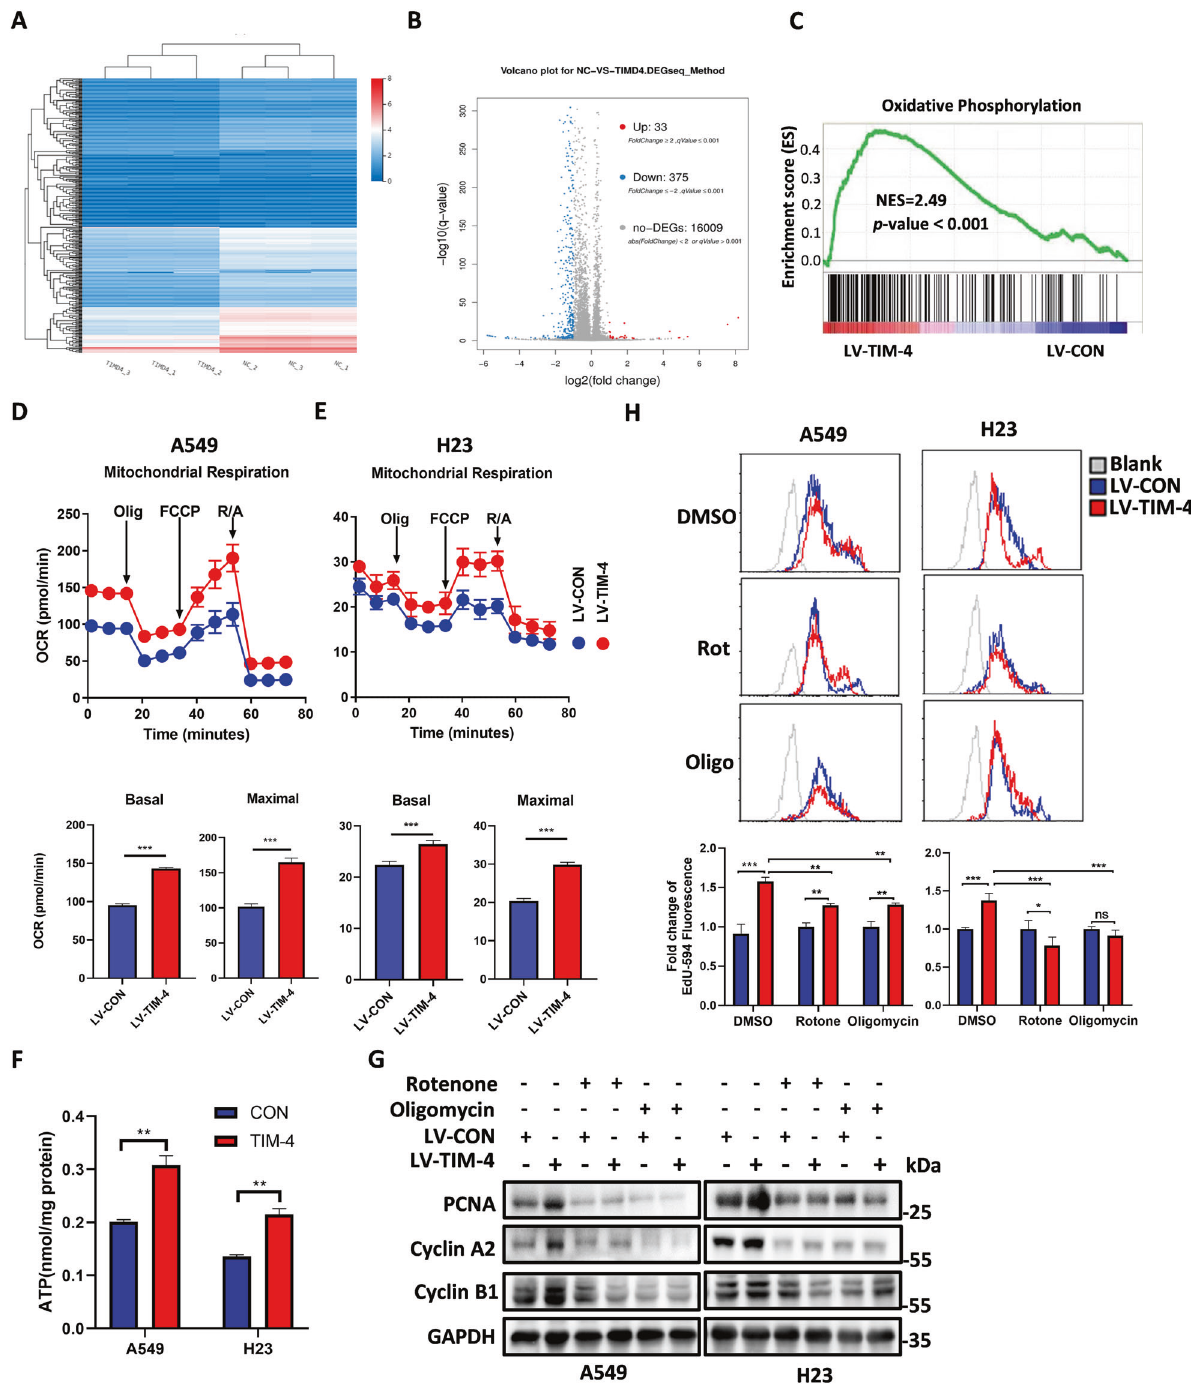
Fig. 1 TIM-4 overexpression enhances oxidative phosphorylation level of lung cancer cells. A , B A549 cells overexpressing TIM-4 and control cells were analyzed by RNA-Seq, and cluster analysis and differentially expressed genes (false discovery rate [FDR] < 0.05, fold change ≥ 2) were visualized in a heatmap and volcano fi gure. C RNA-Seq analysis in A549 cells. GSEA was used to analyze the OXPHOS-related genes with differential mRNA levels. Normalized enrichment score (NES), P -value <0.05 is considered signi fi cant. D , E Mitochondrial oxygen consumption rate (OCR), mitochondrial basal respiration and maximal respiration of A549 cells and H23 cells. F ATP production in A549 and H23 cells overexpressing TIM-4 and the control cells. G , H A549 and H23 cells overexpressing TIM-4 and control cells were treated with rotenone (Rot) (0.5 μ M) and oligomycin (Oligo) (2 μ M) for 48 h, and PCNA, Cyclin A2, and Cyclin B1 expression were analyzed by western blotting, while Edu staining was measured by fl ow cytometry assay. Three independent experiments were conducted for each result and error bars represent SEM per group in one experiment. Data were analyzed using Student ’ s t test (two-tailed unpaired t test) for ( D – F ) and ( H ). ns means non-signi fi cance; * P < 0.05; ** P < 0.01; *** P < 0.001.